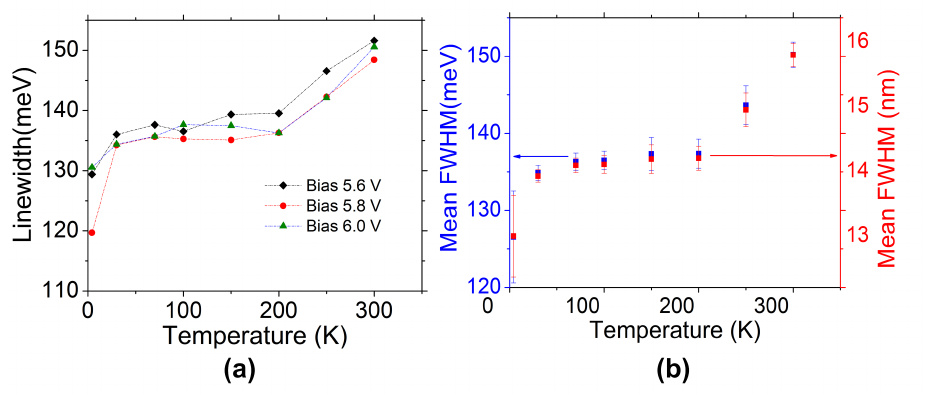
Figure 5. ( a ) Linewidth vs. temperature curves when bias voltages were 5.6 V, 5.8 V, and 6.0 V. ( b ) The mean linewidth curves of ( a ) in the form of both wavelength (right axis) and equivalent energy (left